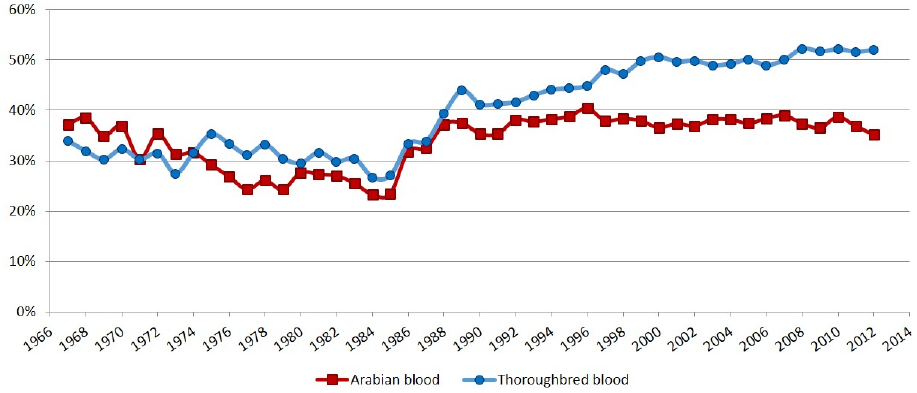
Figure 3. The percentages of Arabian and Thoroughbred blood by year of birth.